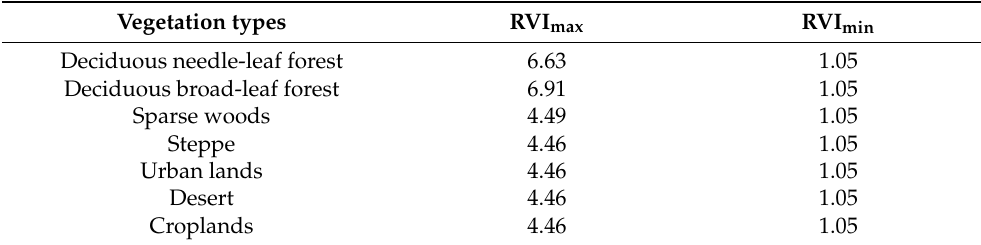
Table 2. Maximum and minimum RVI of different vegetation types.